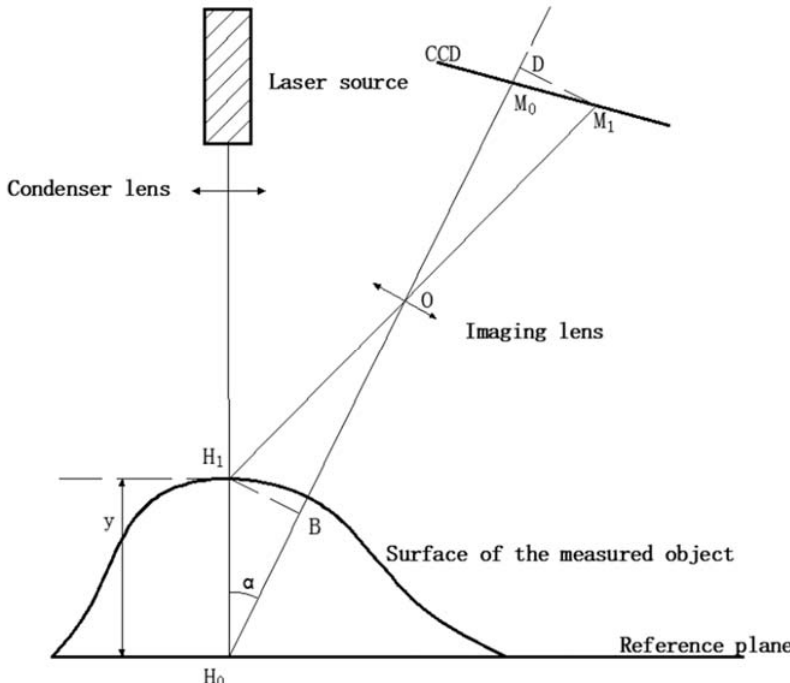
Figure 1. The principle of triangulation.